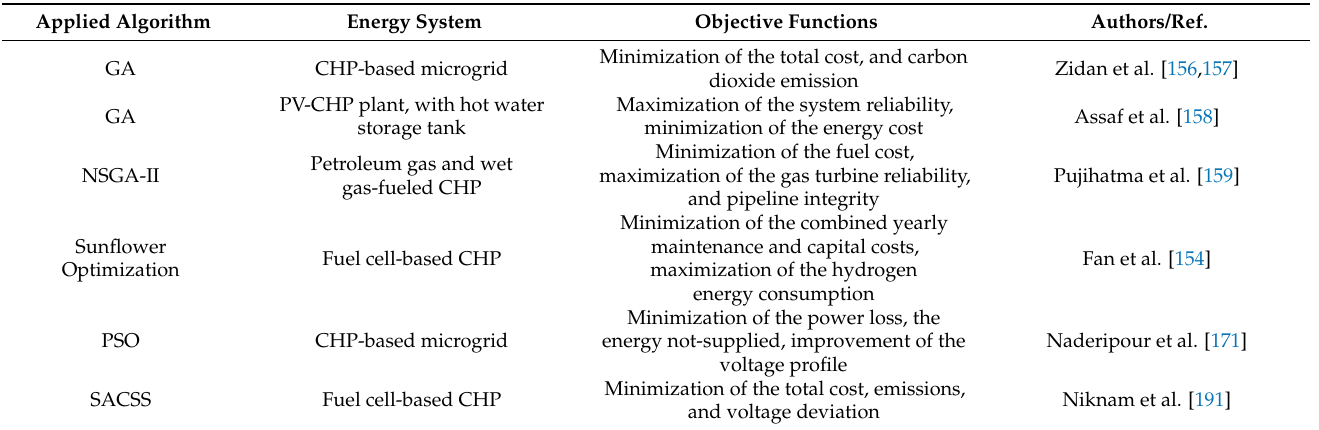
Table 9. Multi-objective sizing issues of CHP energy systems.